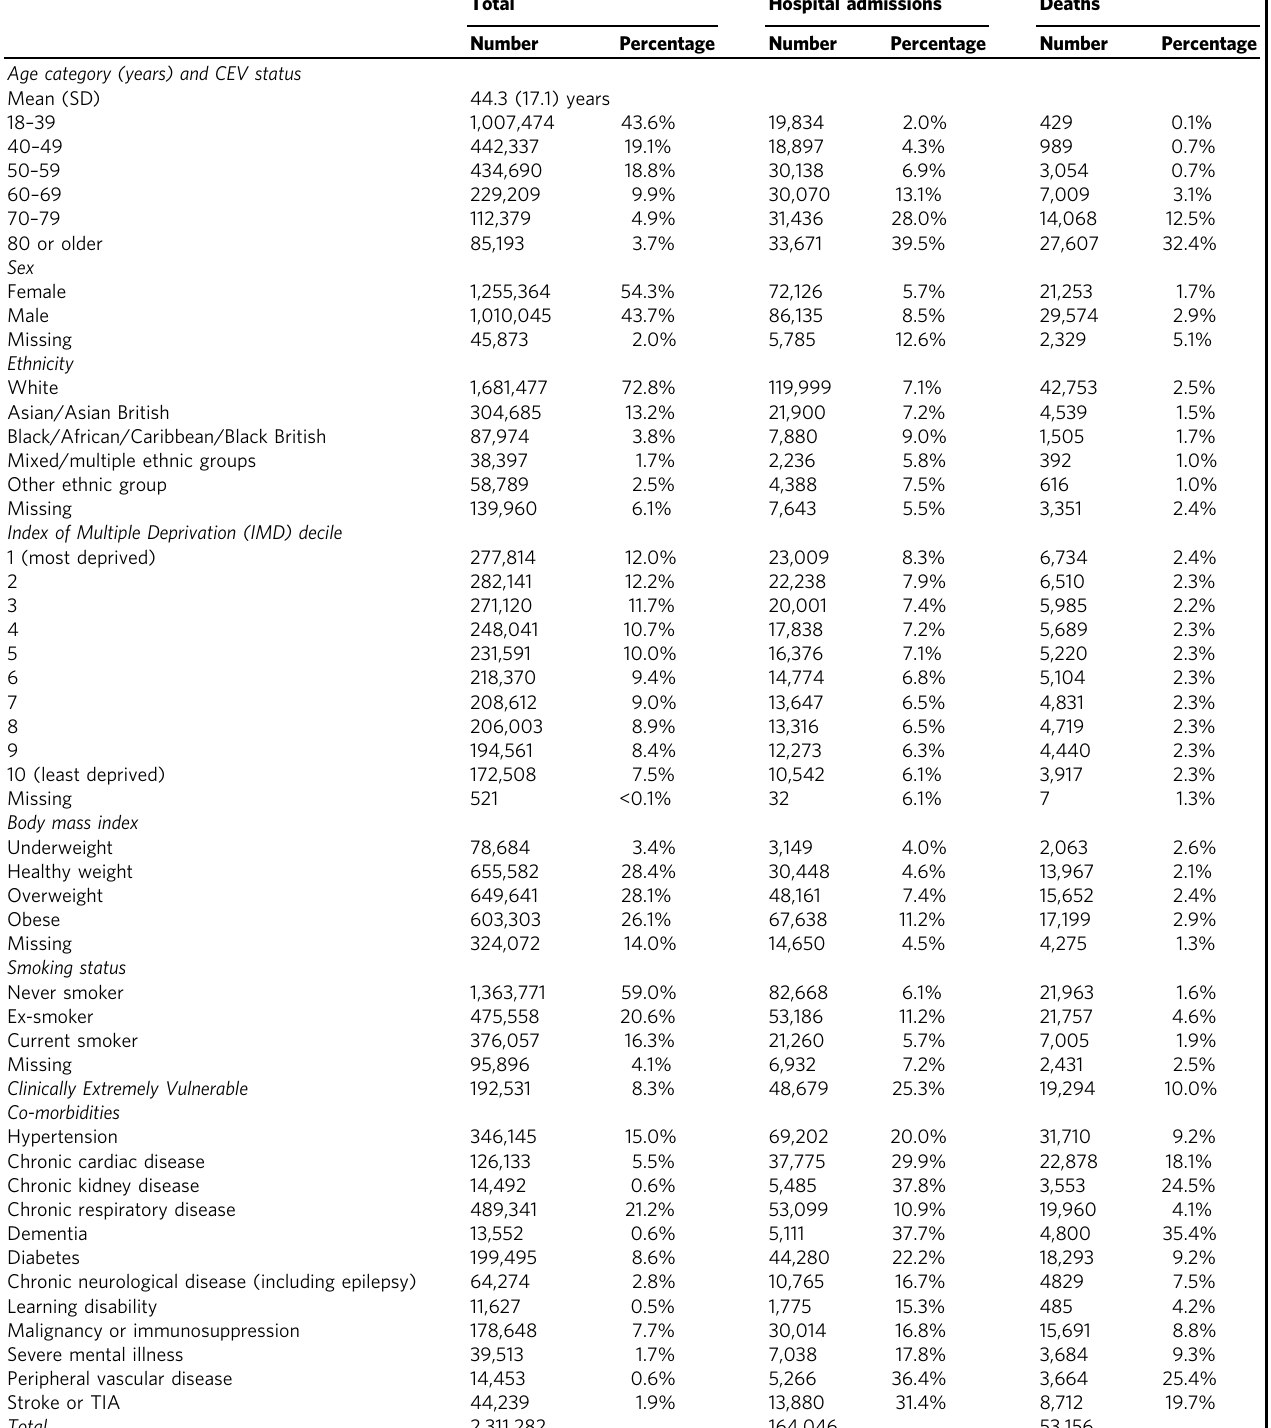
Table 1 Characteristics of the study population with hospital admissions and deaths within 28 days ( N =